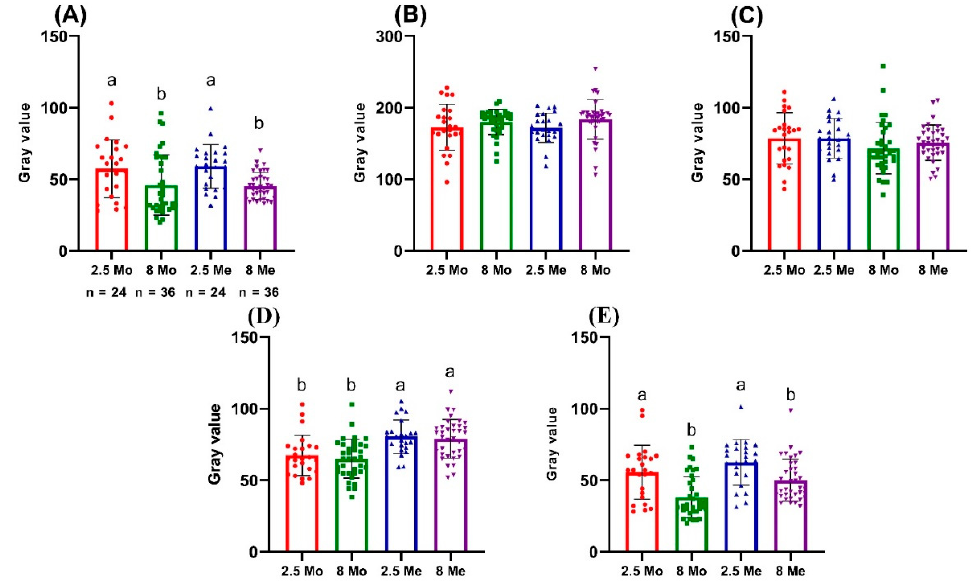
Figure 5. Comparison of MoGV and MeGV parameters in 2.5- and 8-month-old fish. The value ( p < 0.05) from one-way ANOVA with comparison using Tukey’s post hoc analysis. Different super- script letters (a,b) indicate statistically significant differences between the experimental groups. ( A ) BROI zone; ( B ) LBRIO zone; ( C ) RROI zone; ( D ) RSGC zone; ( E ) BBCF zone.